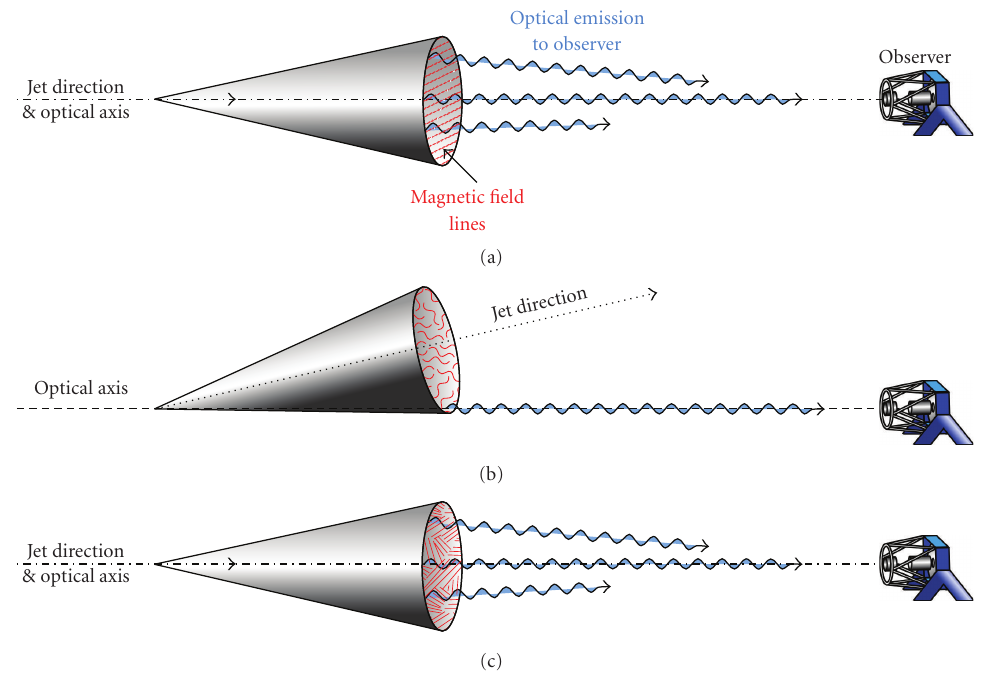
Figure 12: Competing models of GRB magnetic field structure for standard fireball model: (a) large-scale ordered magnetic field (favoured for GRB 090102); (b) tangled magnetic field in shock front and line of sight close to jet edge, and (c) shock front contains some independent patches of locally ordered magnetic fields